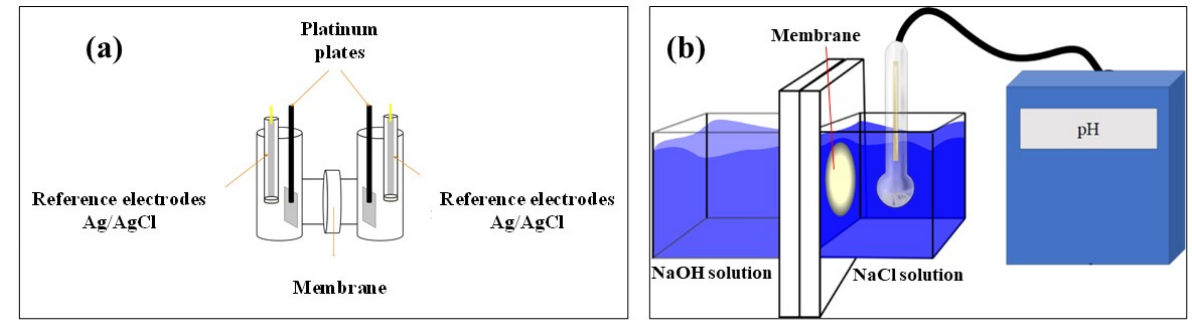
Figure 1. ( a ) H cell configuration for anionic conductivity. ( b )Two compartment cell for hydroxide ions exchange rate determination.